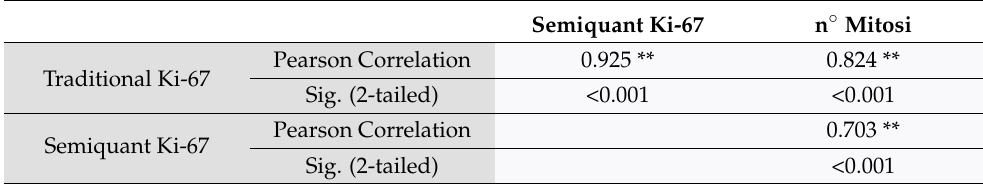
Figure 2. Evaluation of Ki67 proliferation index: in ( a ) and ( c ) immunostaining with Ki-67, 40× objective. In ( b ) and ( d ) the calculation was performed using specialized software, tumor nuclei considered positive for Ki-67 are indicated in red. Table 2. Correlation among the measure of cellular proliferation. Table 2. Correlation among the measure of cellular proliferation.